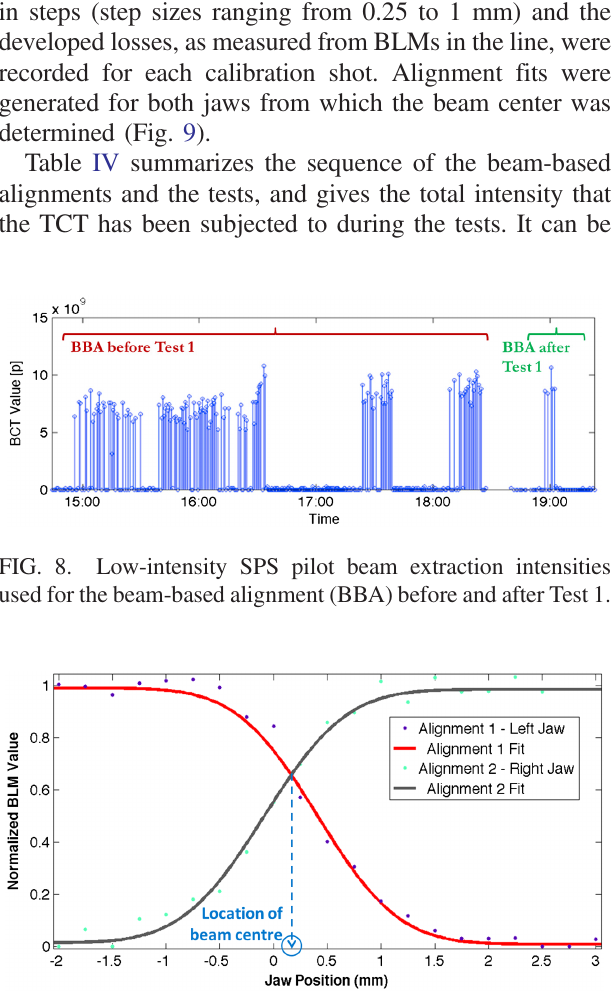
FIG. 9. One example of the alignment fits generated for the beam-based setup, showing movements with the left and right jaws in order to determine the location of the beam